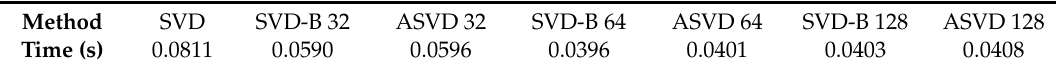
Table 5. Average computational time for the noise level estimation algorithms in the SVD